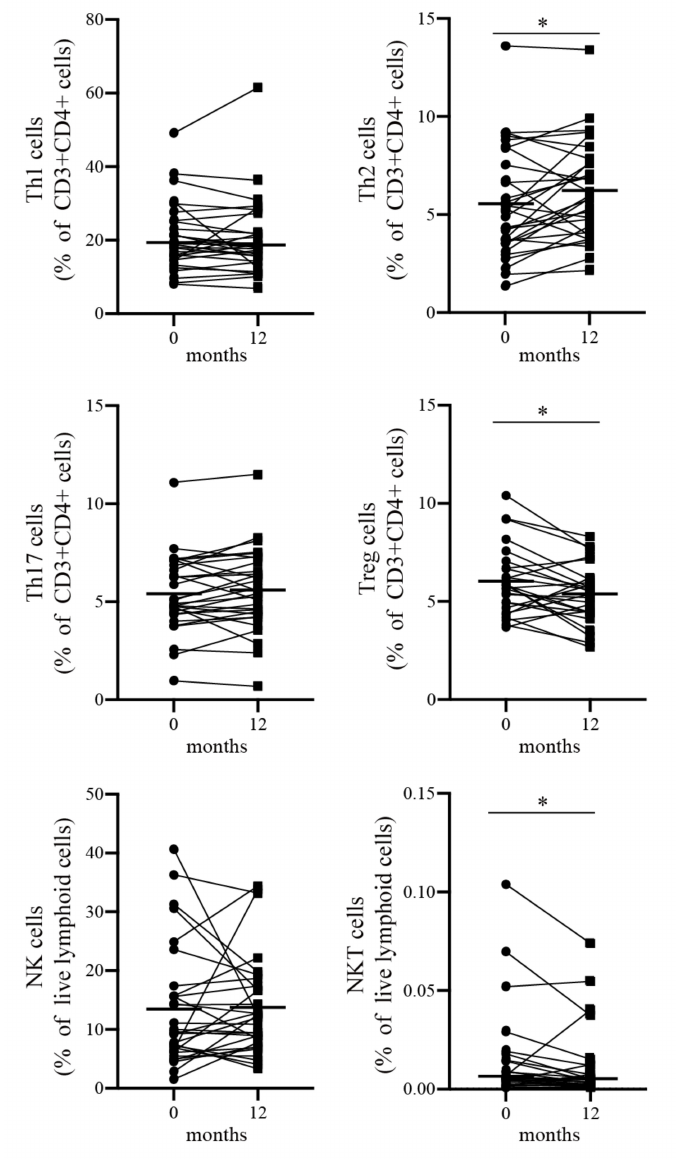
Figure 2. Changes in immune cell profile from baseline to 12 months after treatment with benral- izumab. The frequencies of circulating Th1 cells, Th2 cells, Th17 cells, Tregs, NK cells, and NKT cells are plotted. Abbreviations: NK, natural killer; NKT, natural killer T; Th, helper T; Treg, regulatory T. Bars indicate median values. * p <